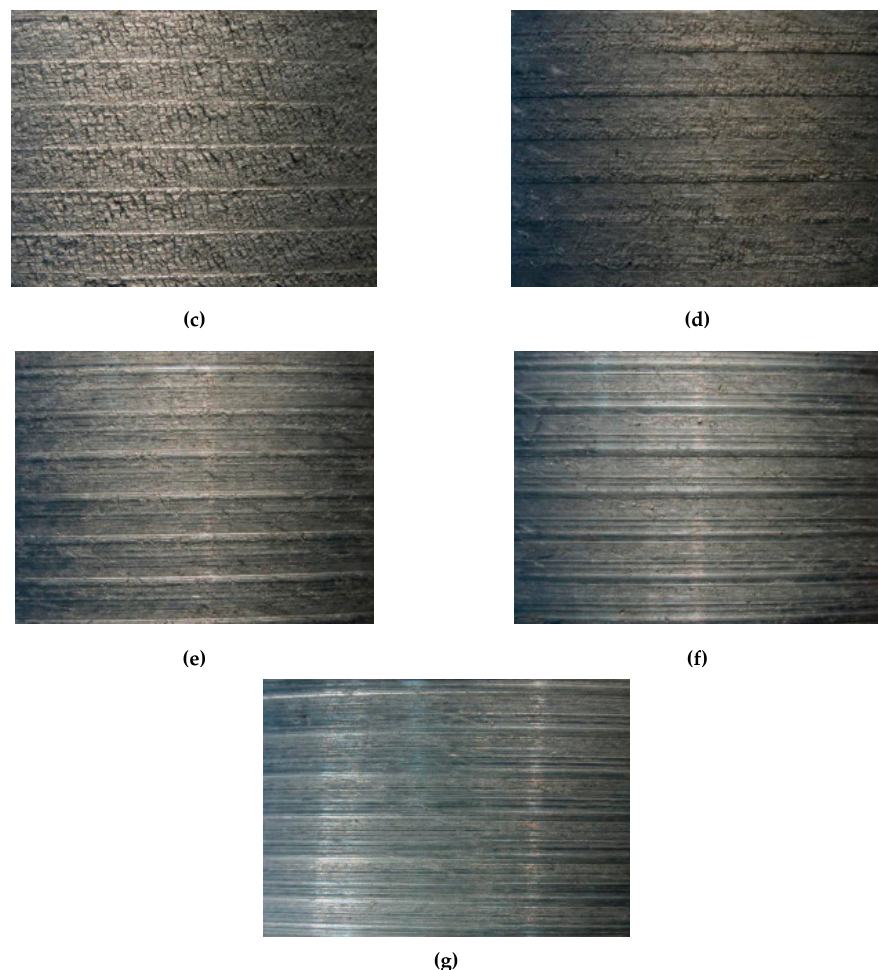
Figure 13. Images with a 4-fold magnification of a surfaces after grooving with DDCC insert in the range of: ( a ) v c = 50 m/min; ( b ) v c = 100 m/min; ( c ) v c = 200 m/min; ( d ) v c = 400 m/min; ( e ) v c = 600 m/min; ( f ) v c = 800 m/min; ( g ) v c = 1000 m/min.